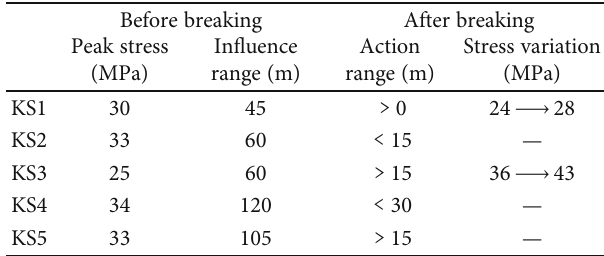
Table 5: Range of stress in fl uence before and after strata fracturing. Before